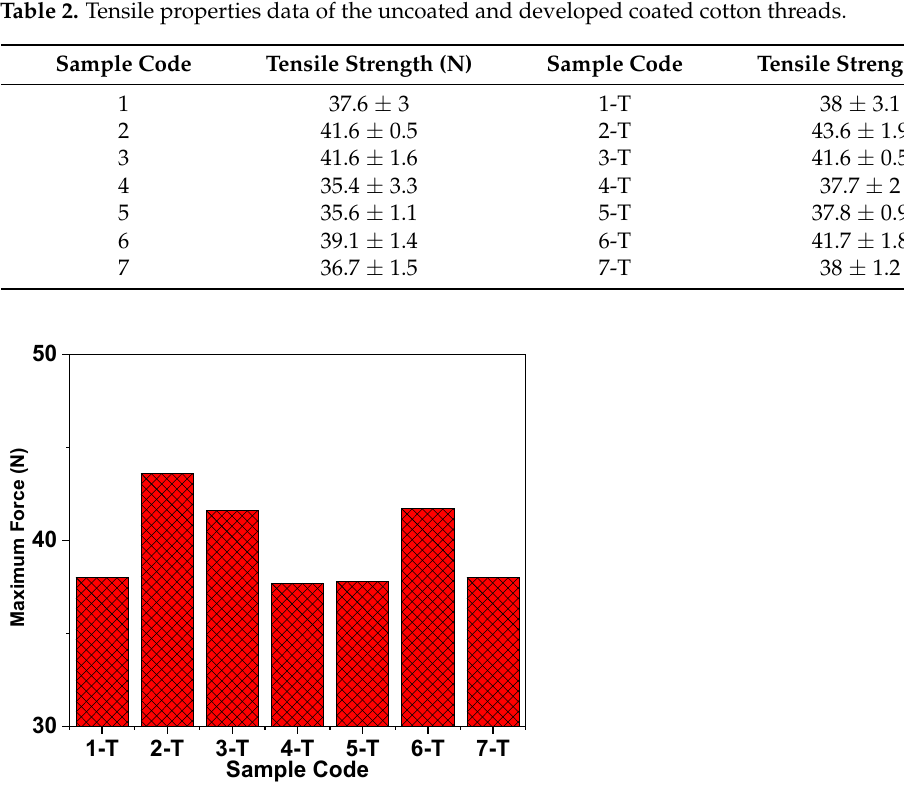
Figure 5. Colum bar graph presenting the tensile strength performance of different coated samples presented from 1 to 7-T as T refers to treated threads.